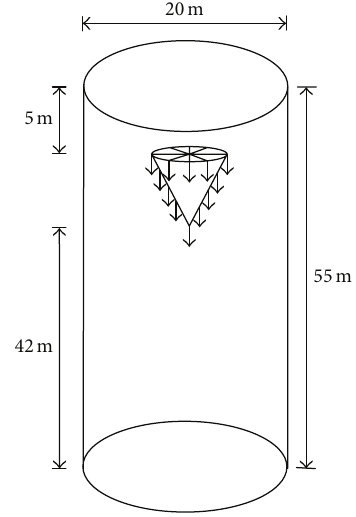
Figure 3: Geometrical shape of fluid